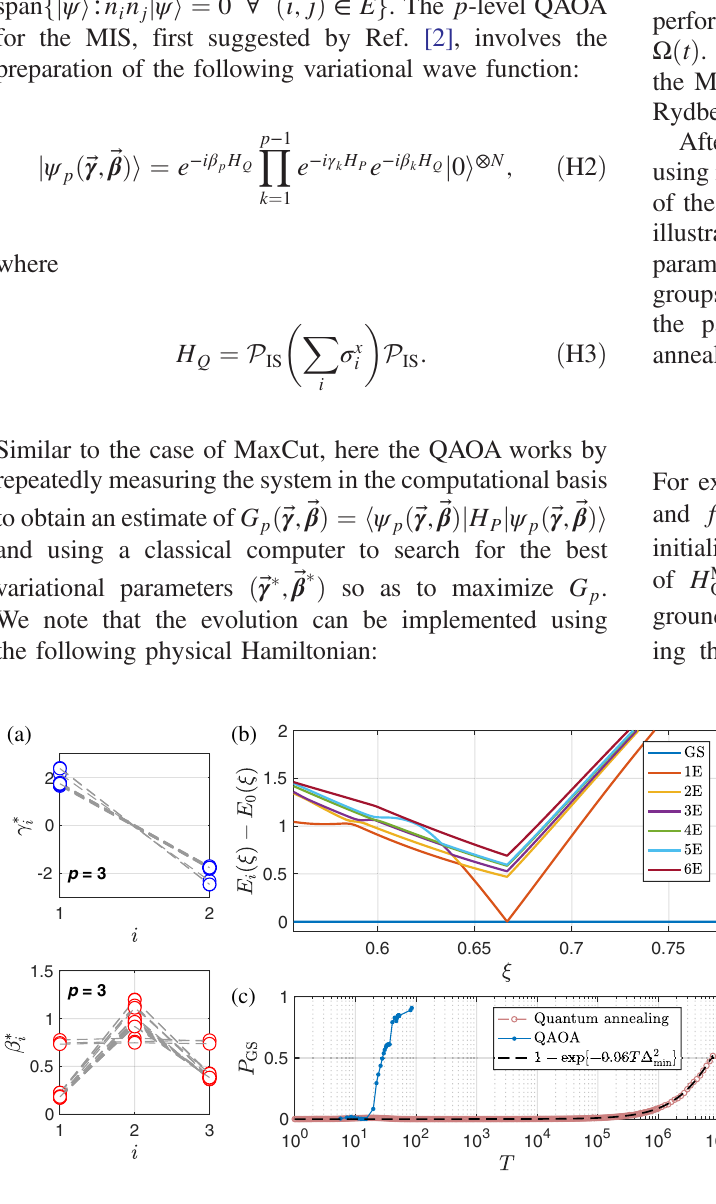
FIG. 15. (a) Pattern in the optimal QAOA parameters at level p ¼ 3 for 20 random instances of the MIS problem. Each dashed line connects parameters for one particular graph instance. (b) The energy difference relative to the ground state in the quantum annealing protocol of Eq. (H6) for an example 32-vertex MIS instance. The annealing protocol progresses as the parameter ξ increases from 0 to 1. The minimum spectral gap between the ground state (GS) and the first excited state (1E) is Δ performance of quantum annealing and the QAOA on the example instance, in terms of the ground state population at the end of the quantum evolution. The equivalent evolution time for the QAOA is calculated via T annealing schedule converted from optimized 25-level QAOA parameters for the example MIS instance. (e) The population of the system in the instantaneous eigenstates, during the effective annealing schedule that approximates the dynamics under the 25-level QAOA. Here, we observe that the algorithm attempts to transport the system to the fifth excited state, keeping it there before it undergoes a series of anticrossings toward the ground